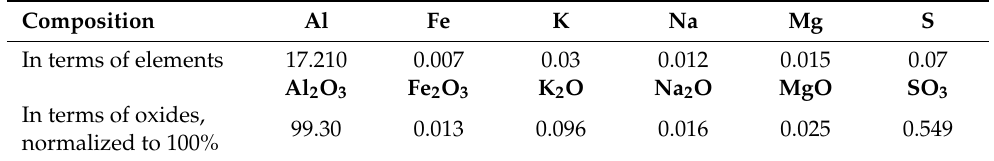
Figure 11. X-ray pattern of the NH 4 -dawsonite (ammonium aluminum carbonate hydroxide) prepared from the alumina precipitate (the orange line). The reference pattern (black) is given from [30]. Table 7. Composition (mass. %) of obtained ammonium aluminum carbonate hydroxide (according to ICP-AES data).